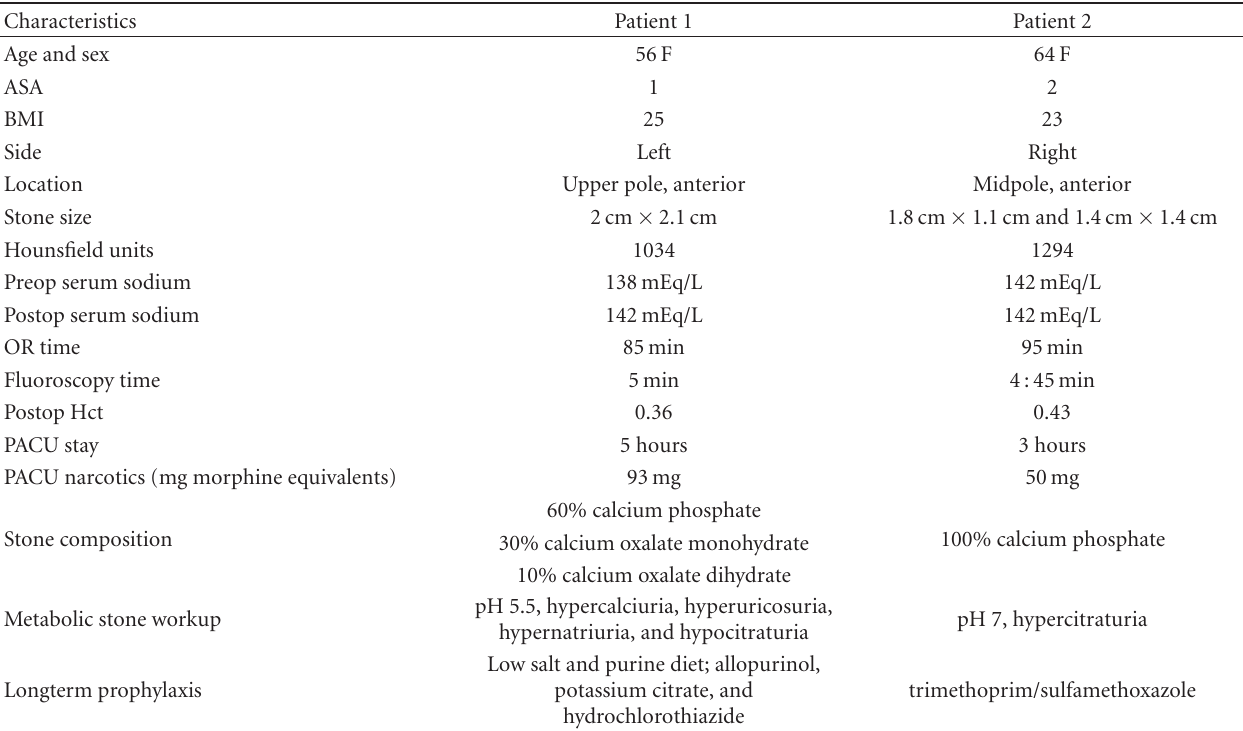
Figure 1: (a) Patient 1: preoperative left retrograde pyelogram demonstrating calyceal diverticulum containing stones. (b) Patient 1: 15- minute film of IVP at 11 months after percutaneous holmium laser fulguration of the calyceal diverticulum demonstrating absence of stones and stable size of the diverticulum. Table 1: Patient